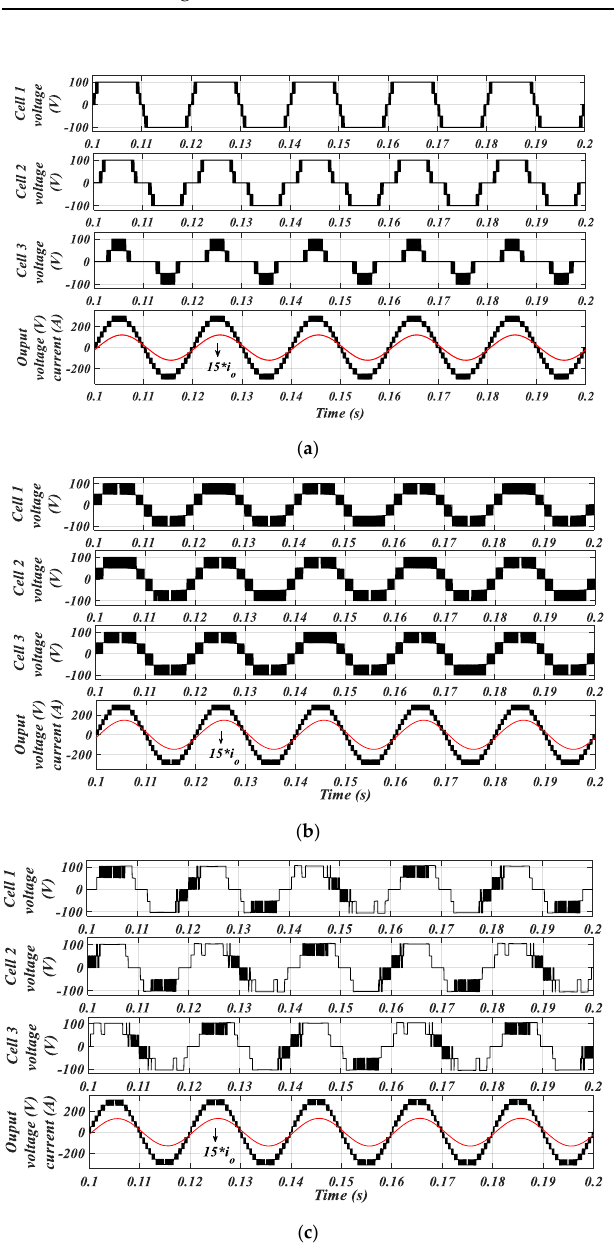
Figure 7. Simulated output voltages and current waveforms with the conventional and proposed SPWM ( a ) IPD SPWM, ( b ) PS SPWM, ( c ) Proposed SPWM